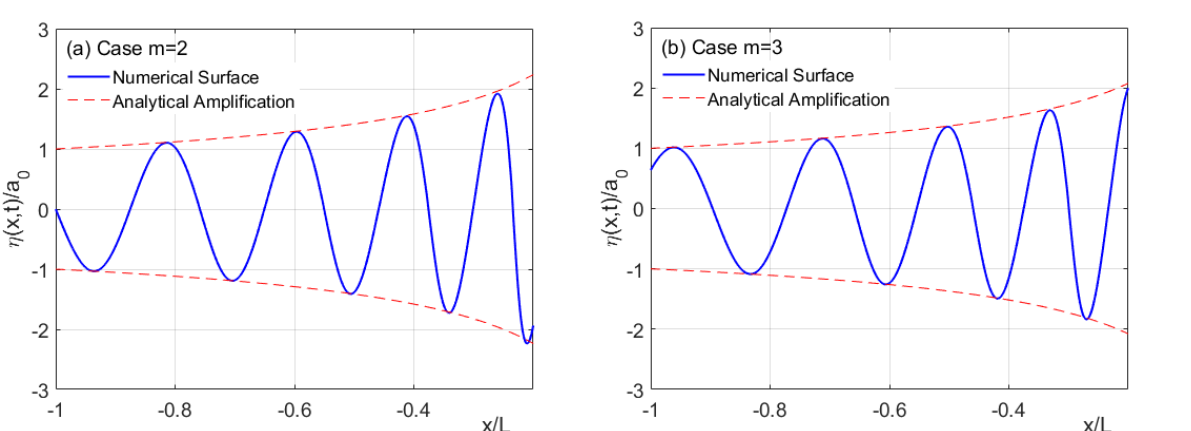
Figure 7. Free surface plot showing the shoaling process of monochromatic waves in a U-shaped bay (16), with varying m : m = 2 ( a ); and m = 3 ( b